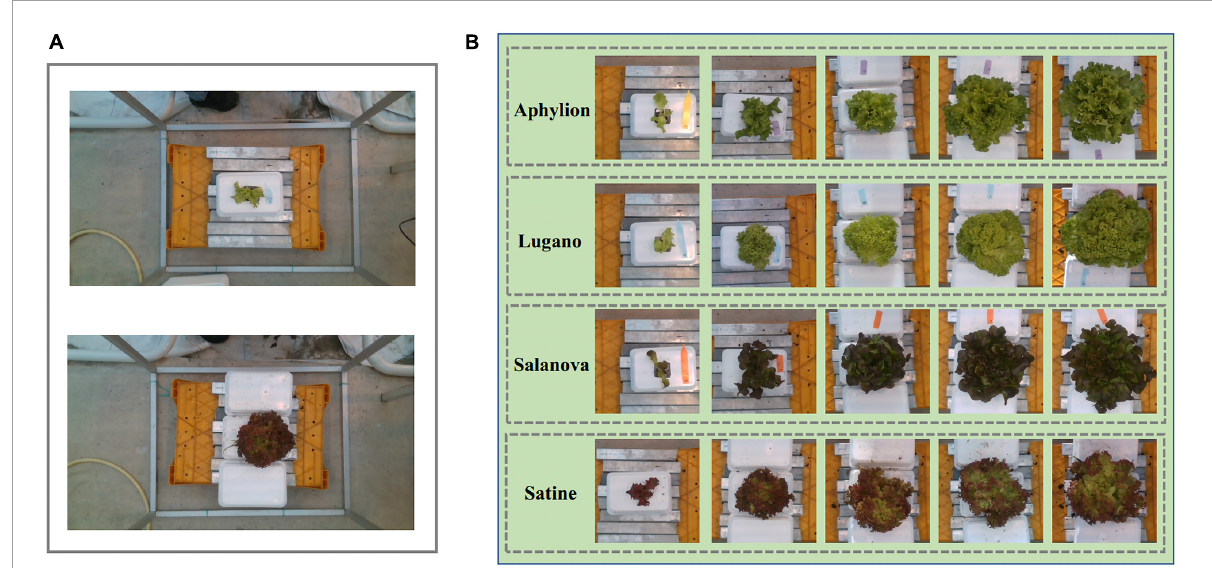
FIGURE1 Examples of the RGB images from the public dataset of the 3rd international challenge on autonomous greenhouses. (A) The original images, in which the lettuce only accounts for a small proportion. (B) The cultivar of Aphylion, Salanova, Satine, and Lugano at different growth stages in the